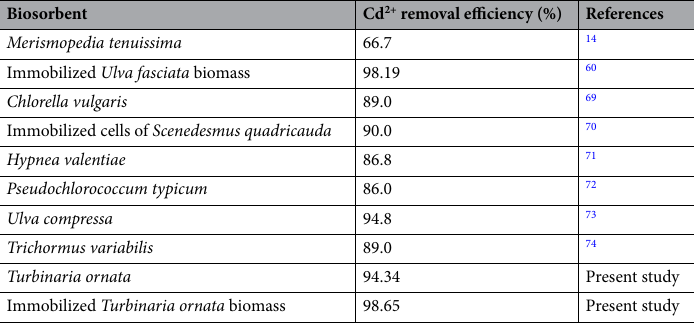
Table 5. Maximum removal efficiency of Cd 2+ ions by low-cost